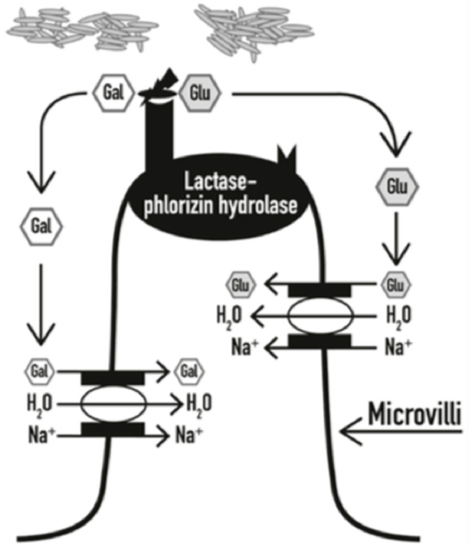
Figure 2. Lactose hydrolysis and rapid absorption at the brush border of the small intestine (as taken from [1]).